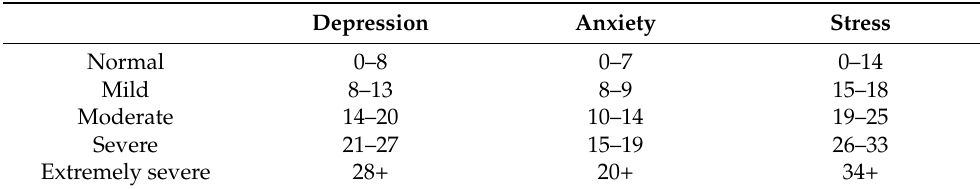
Table 1. The severity labels used to describe the range of scores in the population of the DASS-21 multiplied by 2. Depression Anxiety Stress